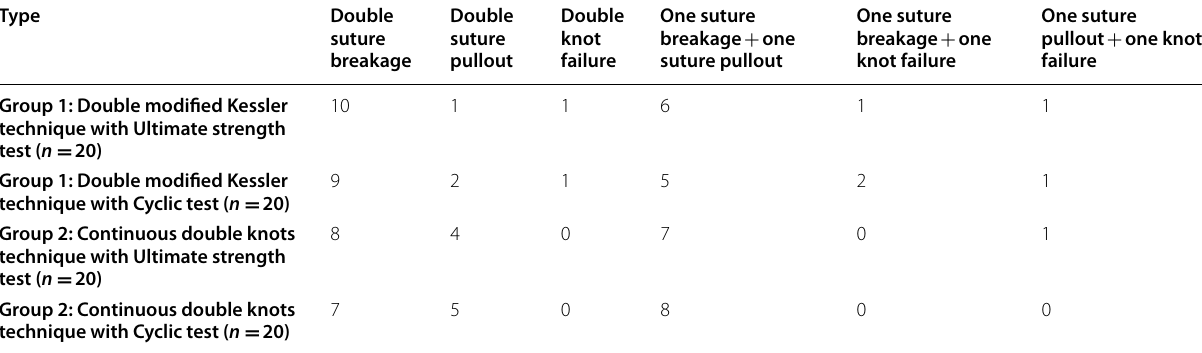
Table 2 Failure modes of the double-modified Kessler technique compared with the continuous double knots technique